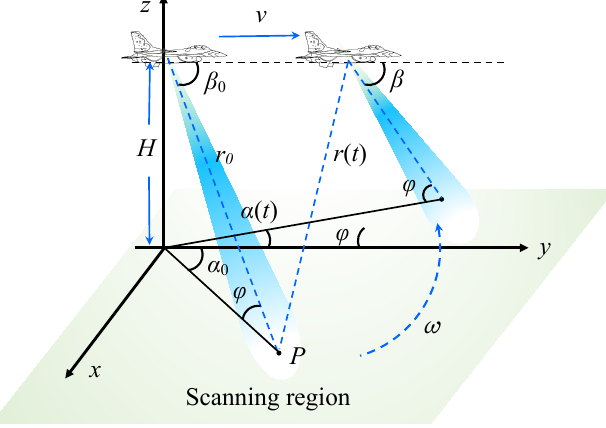
Figure 1. Schematic diagram of airborne radar scanning